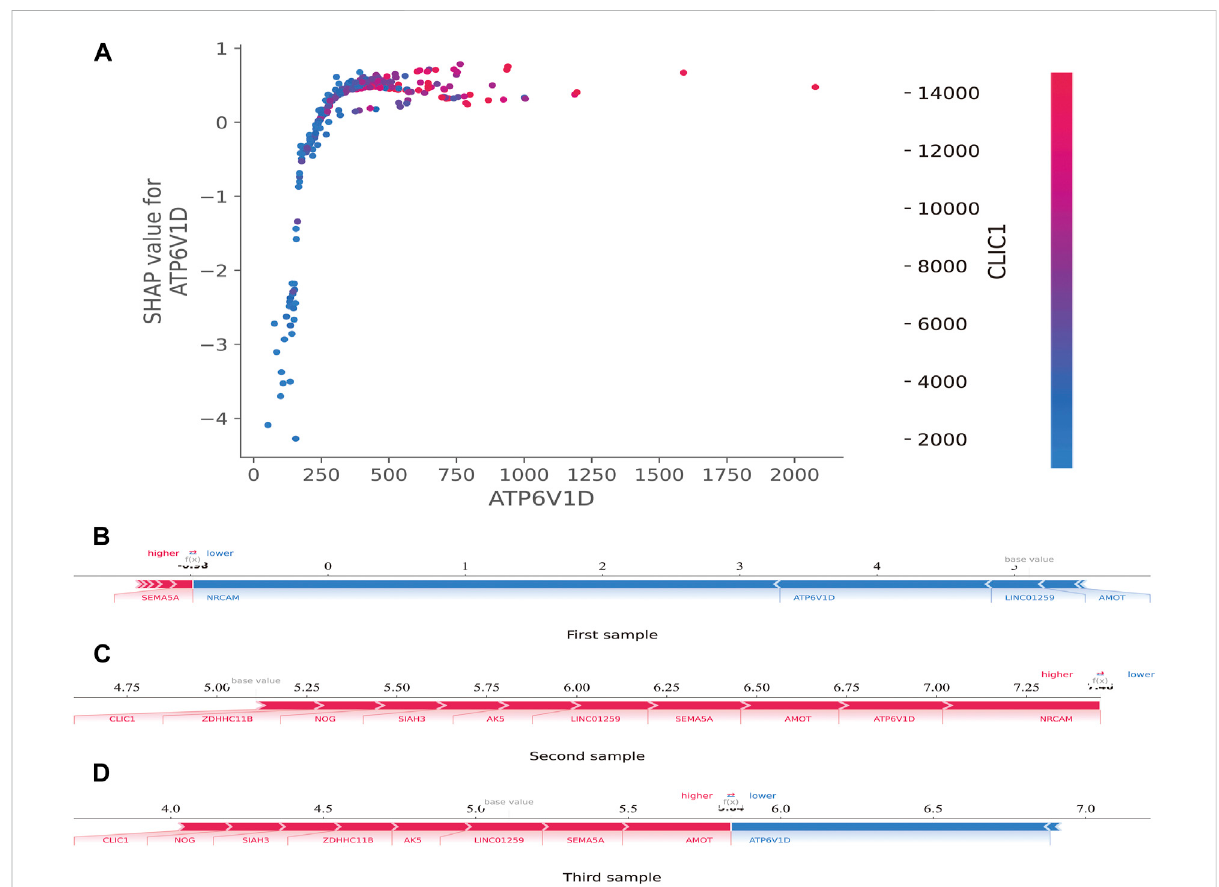
FIGURE 7 SHAP dependence and force plots. (A) : SHAP dependence plot. Each point represents a sample; the horizontal axis is the eigenvalue of the feature, ATP6V1D ;theverticalaxisindicatestheSHAPvalueofthefeature, ATP6V1D ,andthecolorindicatestheeigenvalueofthefeature, CLIC1 .For samples with higher CLIC1 eigenvalues (red), the in fl uence of the feature, ATP6V1D, was greater (the vertical axis SHAP value was higher). (B) : SHAP force plot. The horizontal axis is the SHAP value. Blue indicates that the feature has a negative impact on the prediction (arrow to the left, SHAP valuedecreases);redindicatesthatthefeaturehasapositiveimpactontheprediction(arrowtotheright,SHAPvalueincreases).Onthenumberaxis, thebase value ismarked above thehorizontal axis, which is theaverage f(x)value ofall samples, and f(x)is marked above thehorizontalaxis, which is theaverageSHAPvalueafterthesamplesareaggregated, thatis,themodelpredictsthemeanvalue.Belowthehorizontalaxisarethekeygenesthat in fl uence the outcomes of this